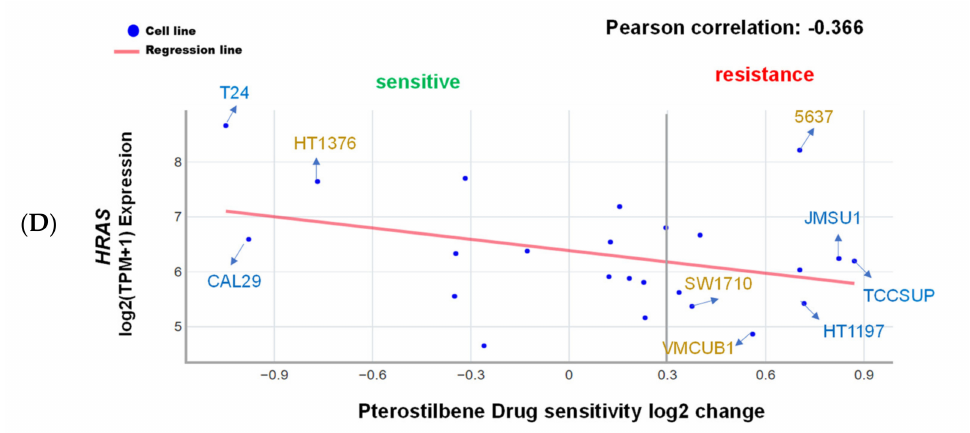
Figure 1. Pterostilbene was predicted to sensitize bladder cancer cells with oncogenic HRAS via bioinformatics analysis. ( A ) Mutation frequency of HRAS , NRAS , and KRAS among various primary tissue types. The data were retrieved from the COSMIC database version 91 (https: // cancer.sanger.ac. uk / cosmic). ( B ) HRAS gene expression in normal bladder and bladder urothelial carcinoma tissues. The data were retrieved from the UCSC Xena (http: // xena.ucsc.edu / ). *** p = 0.0001 ( C ) HRAS expression increased sensitivity to gemcitabine in bladder cancer. The Profiling Relative Inhibition Simultaneously in Mixtures (PRISM) database obtained 4518 drug responses across 578 human cancer cell lines by using the barcode ID and the pooled screening of mixtures cell lines. The scatter plots from the PRISM show that gemcitabine treatment was negatively correlated with HRAS expression in bladder cancer. The higher the expression in a cell line, the better the sensitivity to gemcitabine, but not to cisplatin. The x -axis is the drug sensitivity score represented by log2 fold change. The lower the value is, the higher the sensitivity is. The cuto ff is a score of < 0.3. The y -axis is HRAS log2 expression data. ( D ) There was a slightly positive correlation between the sensitivity to pterostilbene and HRAS expression in bladder cancer cell lines. The scatter plot shows that pterostilbene may sensitize the cell lines with a higher expression of HRAS , suggesting the importance of cell line selection for better outcome of pterostilbene treatment. The golden color denotes cisplatin resistance and blue color denotes cisplatin